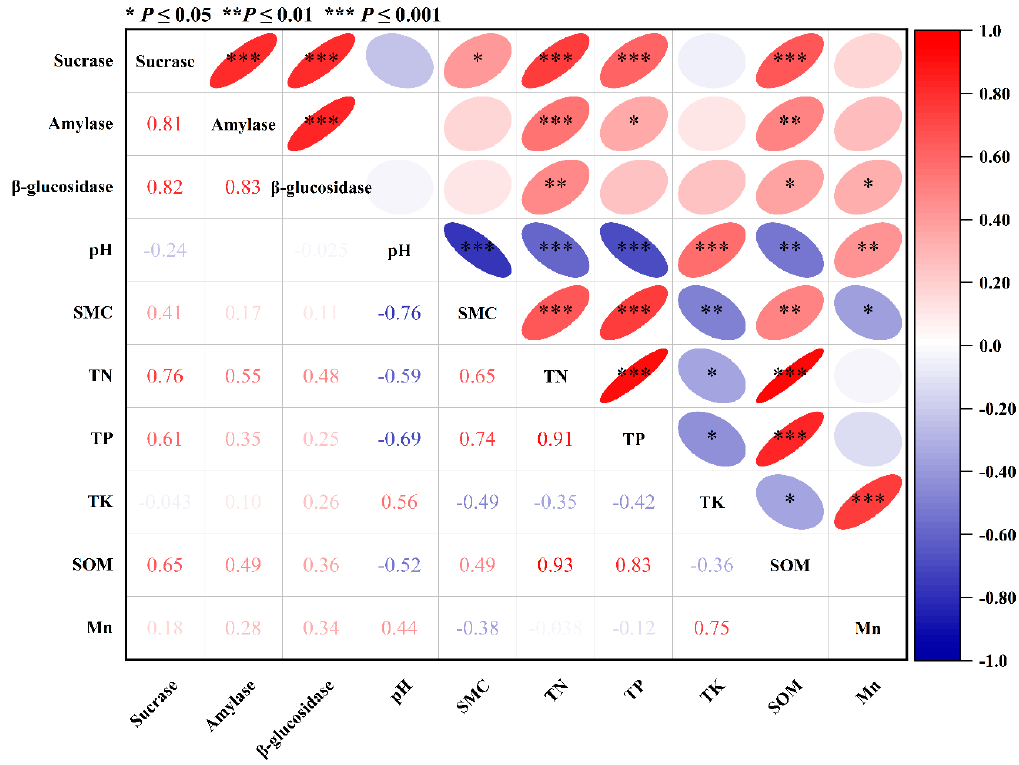
Figure 4. Correlation analysis of environmental factors and soil enzyme activities.